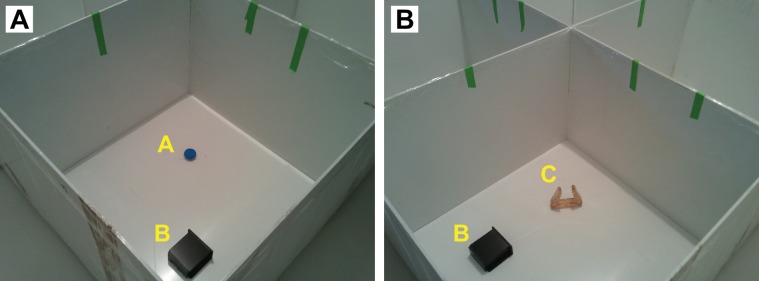
Photographs showing examples of the OF arena with objects (labeled in yellow) during NOR testing.(A) Trial 1 and 2; (B) trial 5. Markings with green tape provide additional spacial clues.